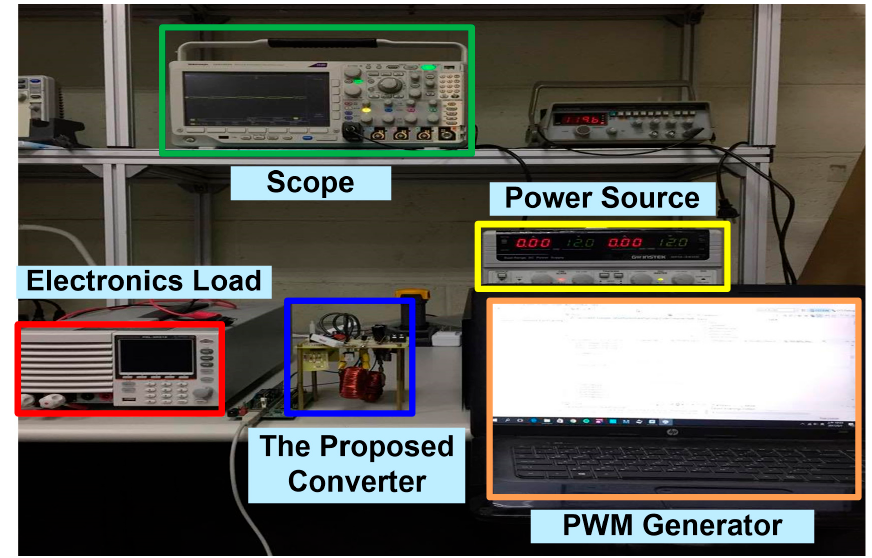
Figure 13. Realized test bench system (the oscilloscope, power source, electronics load, pulse-width modulation (PWM) generator, and the proposed combined boost converter prototype are labeled).